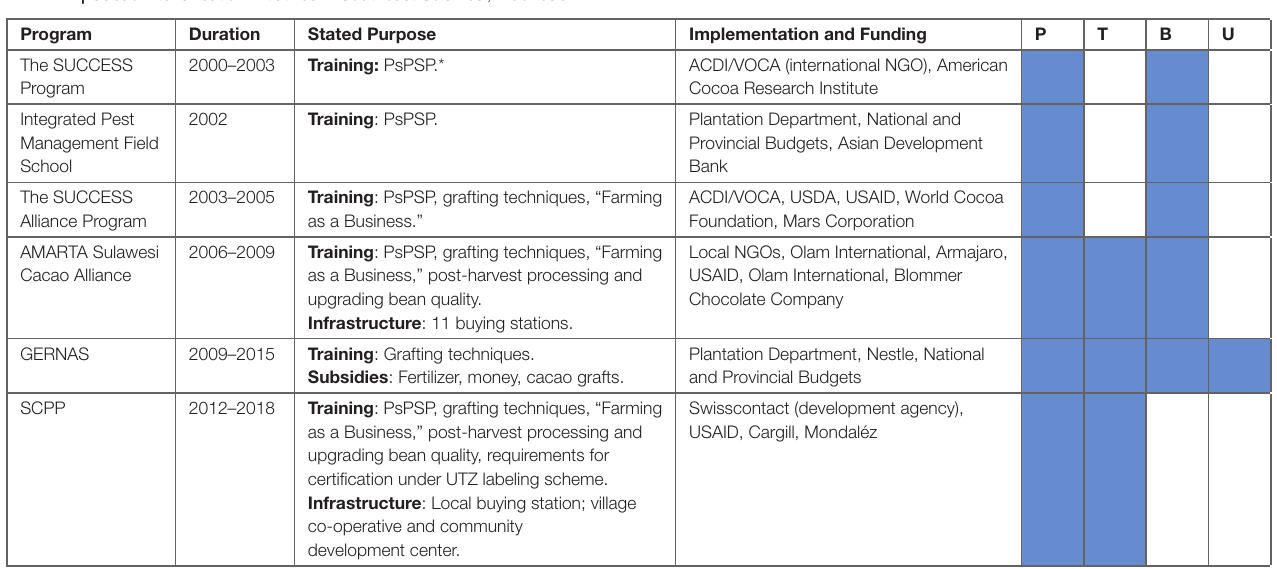
TABLE 1 | Cacao intensification initiatives in Southeast Sulawesi,